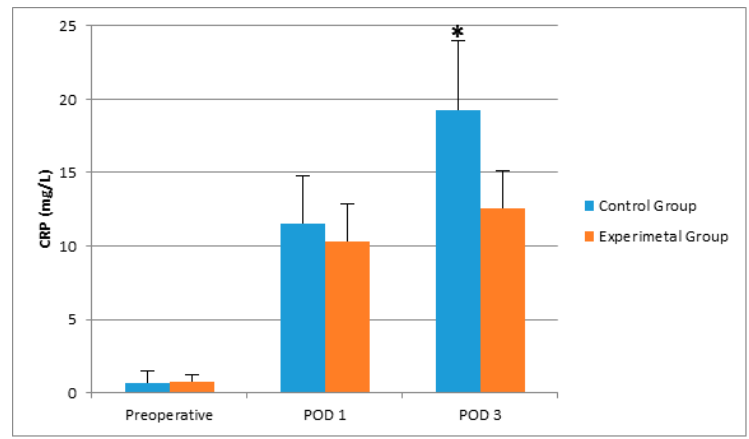
Figure 1. The effects of controlling noise and light in ICU on plasma CRP levels after major abdominal surgery. * p < 0.001 versus experimental group.